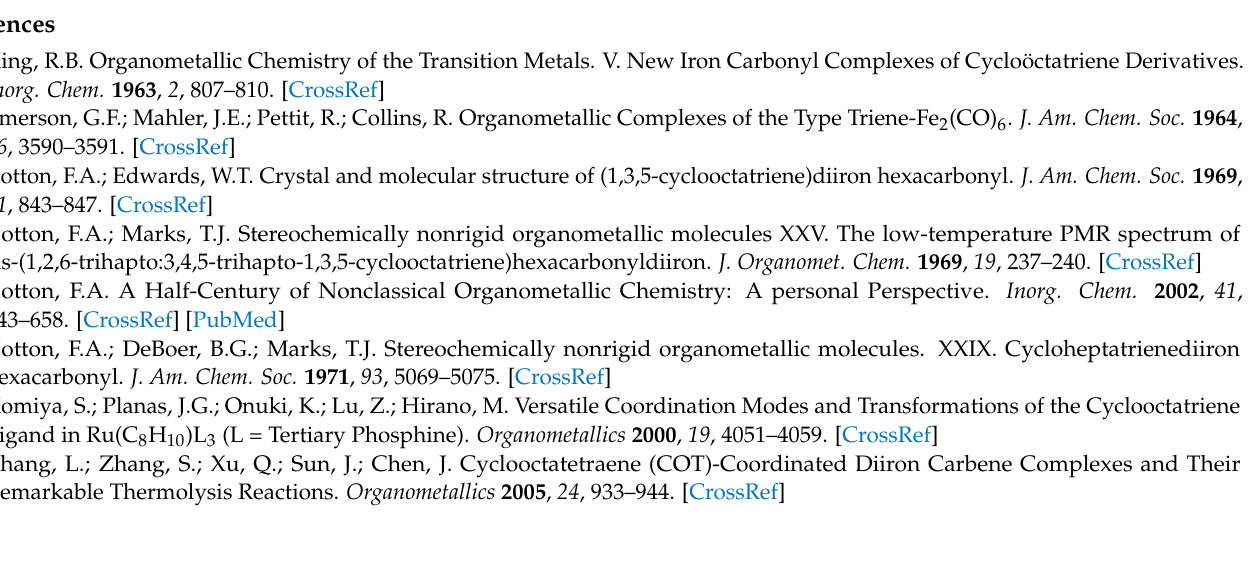
Table S2. Computed proton chemical shifts; Figure S1. Simulated gas phase 1 H-NMR spectra; Figure S2. Linear fitting; Table S3. Cartesian coordinates of optimized